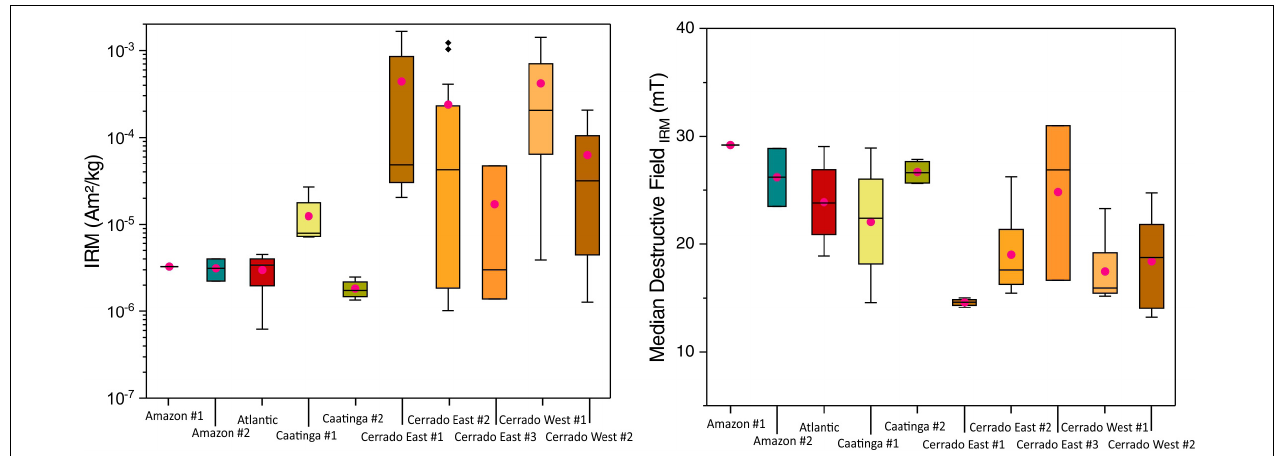
FIGURE 10 | Magnetic properties of the stalagmites organized by their respective biomes. (Left) Isothermal remanent magnetization and biomes. (Right) Median destructive field adjusted from IRM demagnetization curve and its values by each biome. Amazon biome (green), Atlantic biome (red), Caatinga biome (yellow), and Cerrado biome